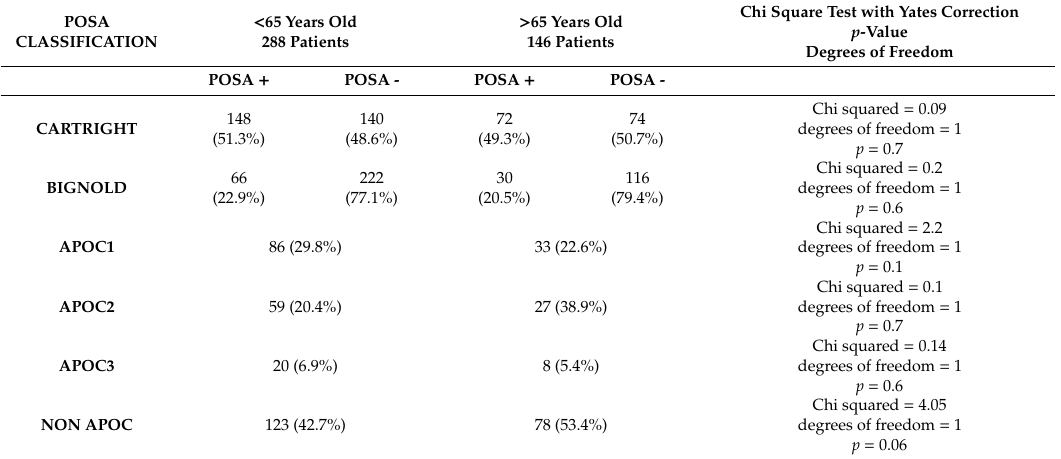
Table 3. Prevalence of position-dependent OSA (POSA) according to Cartwright, Bignold, and Amsterdam Positional OSA Classification (APOC)